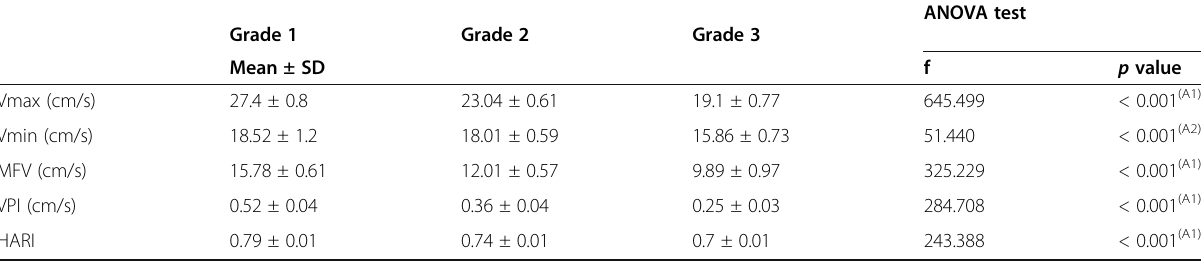
Table 2 Doppler indices comparison between 3 grades of